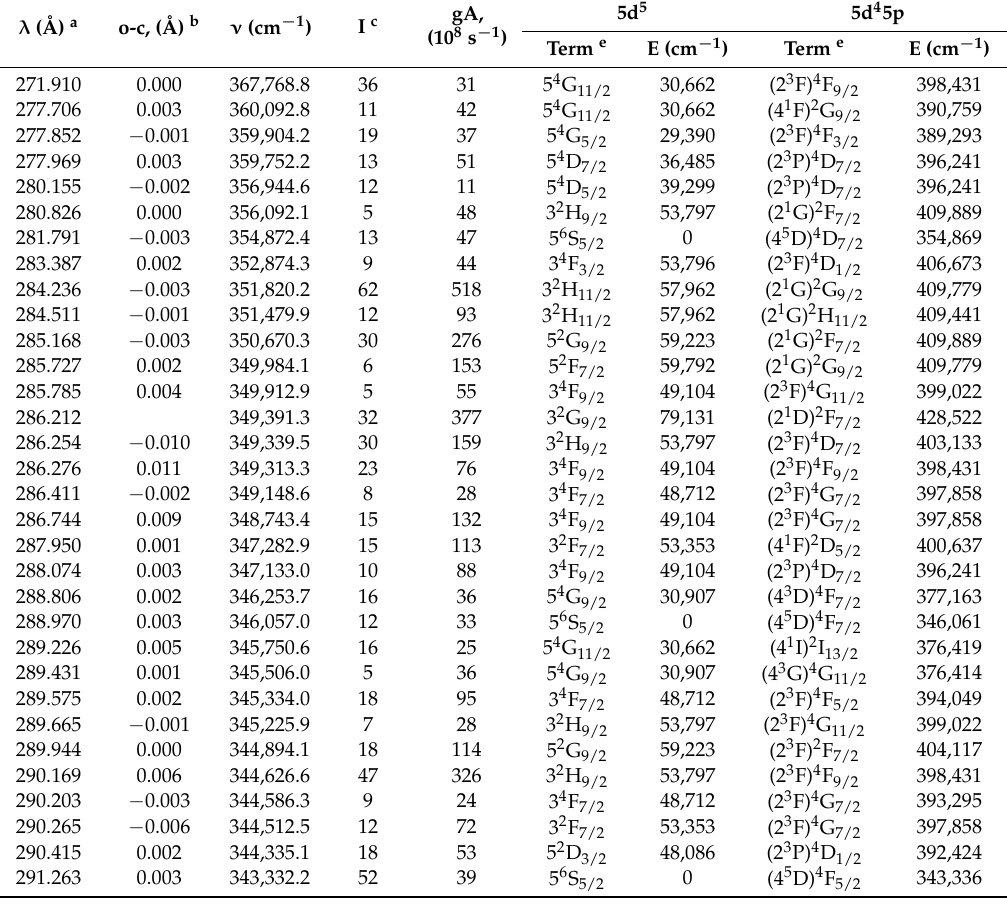
Table A1. Identified lines of the 4d 5 − 4d 4 5p transitions in the spectrum of Ag 6+